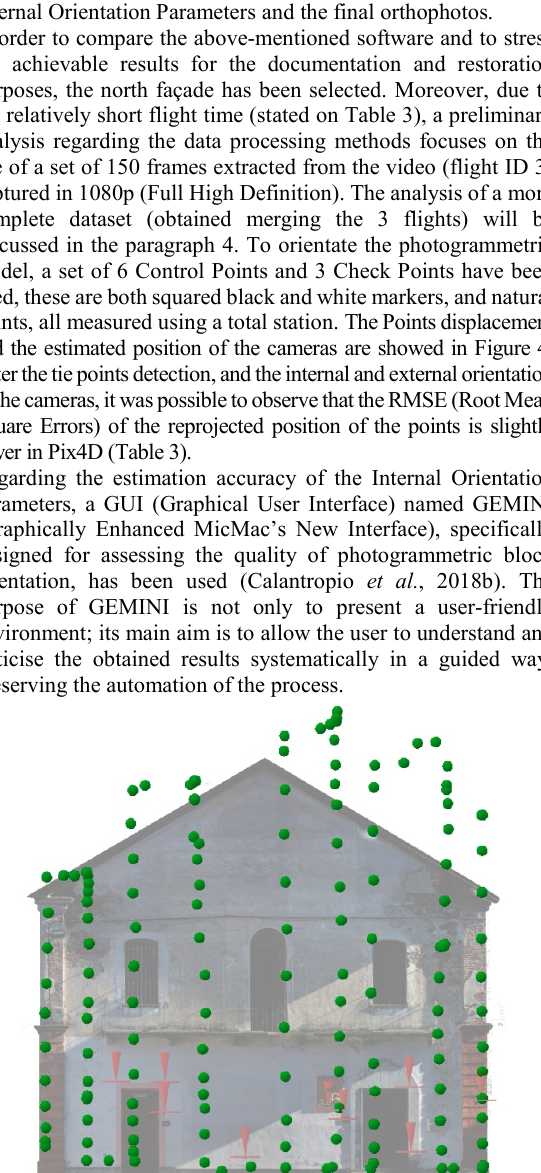
Figure 5. Orthophoto of the north façade generated using Pix4D (left) and MicMac